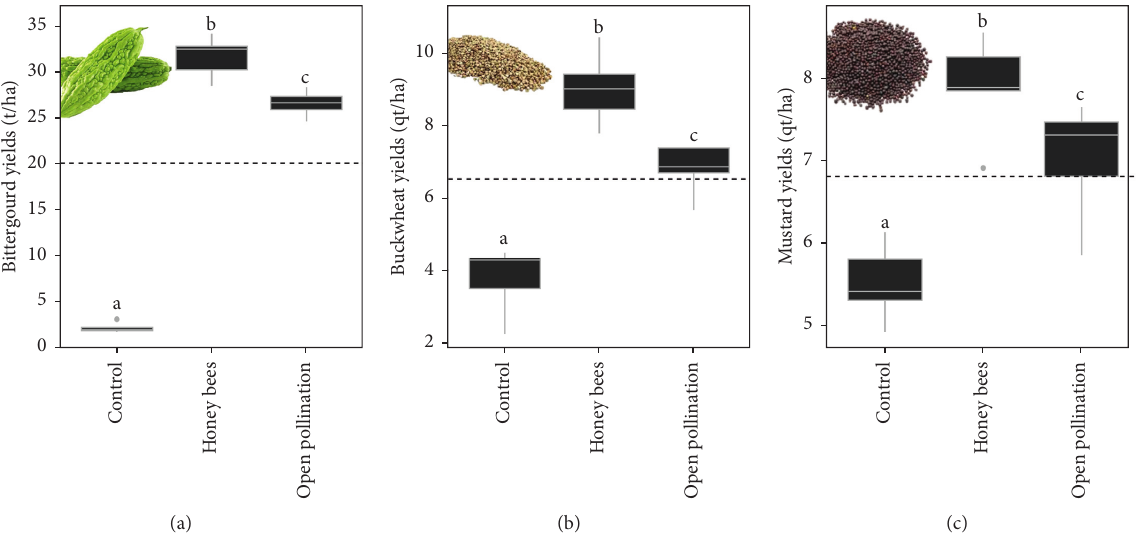
Figure 1: Production of bittergourd, buckwheat, and mustard crops in Nepal. Control � excluding all flower visitors; honeybee hives � adding Apis mellifera beehives; ans open access to insect � flowers freely accessible to any foraging insect. Note . Different letters over boxes indicate a significant difference at a low α -level of 0.05; dashed lines in plots show the average production for every crop: bitter gourd (20.12 tons/ha), buckwheat (6.60 quintal/ha), and mustard (6.81 quintal/ha); and a ton is a tenth of quintal unit.